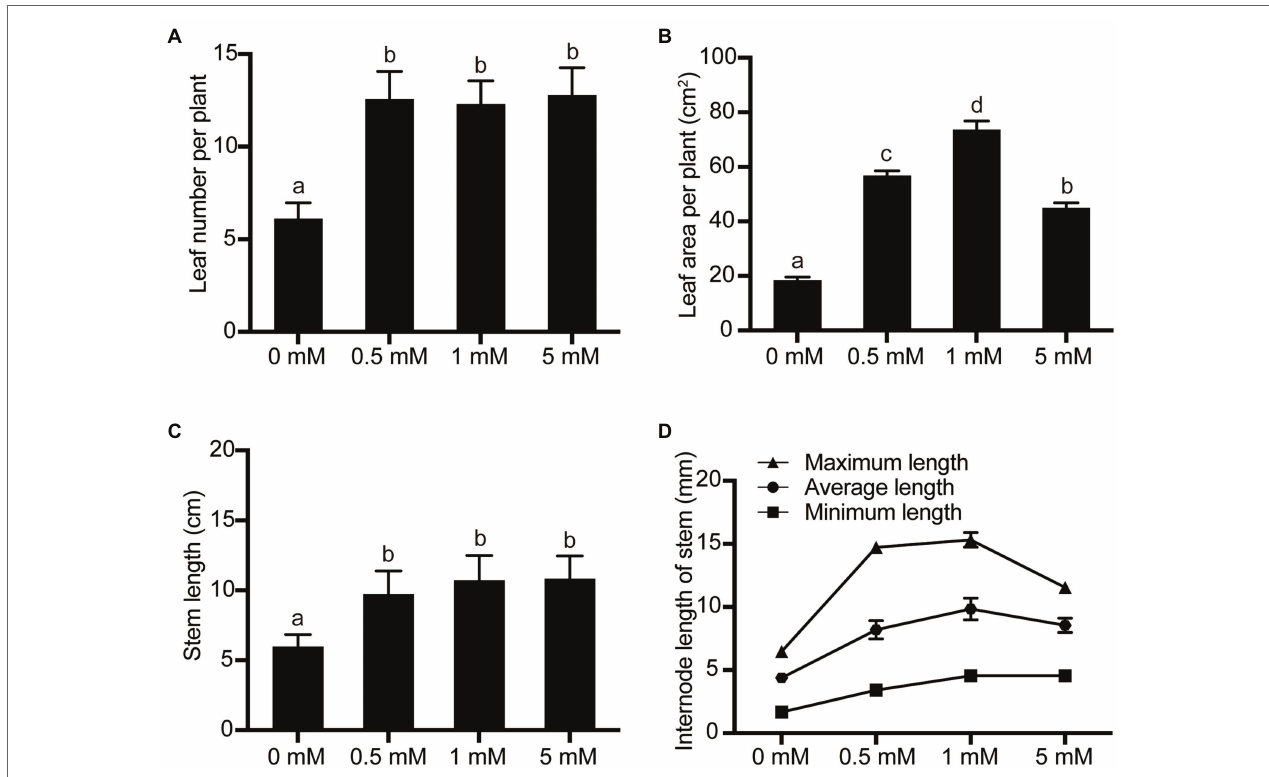
FIGURE 2 | The effects of P treatments on pear seedling shoot growth. (A) The leaf number per pear seedling; (B) The leaf area per pear seedling; (C) The stem length per pear seedling; and (D) The internode length of stem per pear seedling. Data are presented as mean ± standard deviation of three replicates, and each replicate is based on measurements made from three plants. Samples in a bar chart with a common superscript letter are not significantly different ( p > 0.05), according to the Duncan’s multiple range